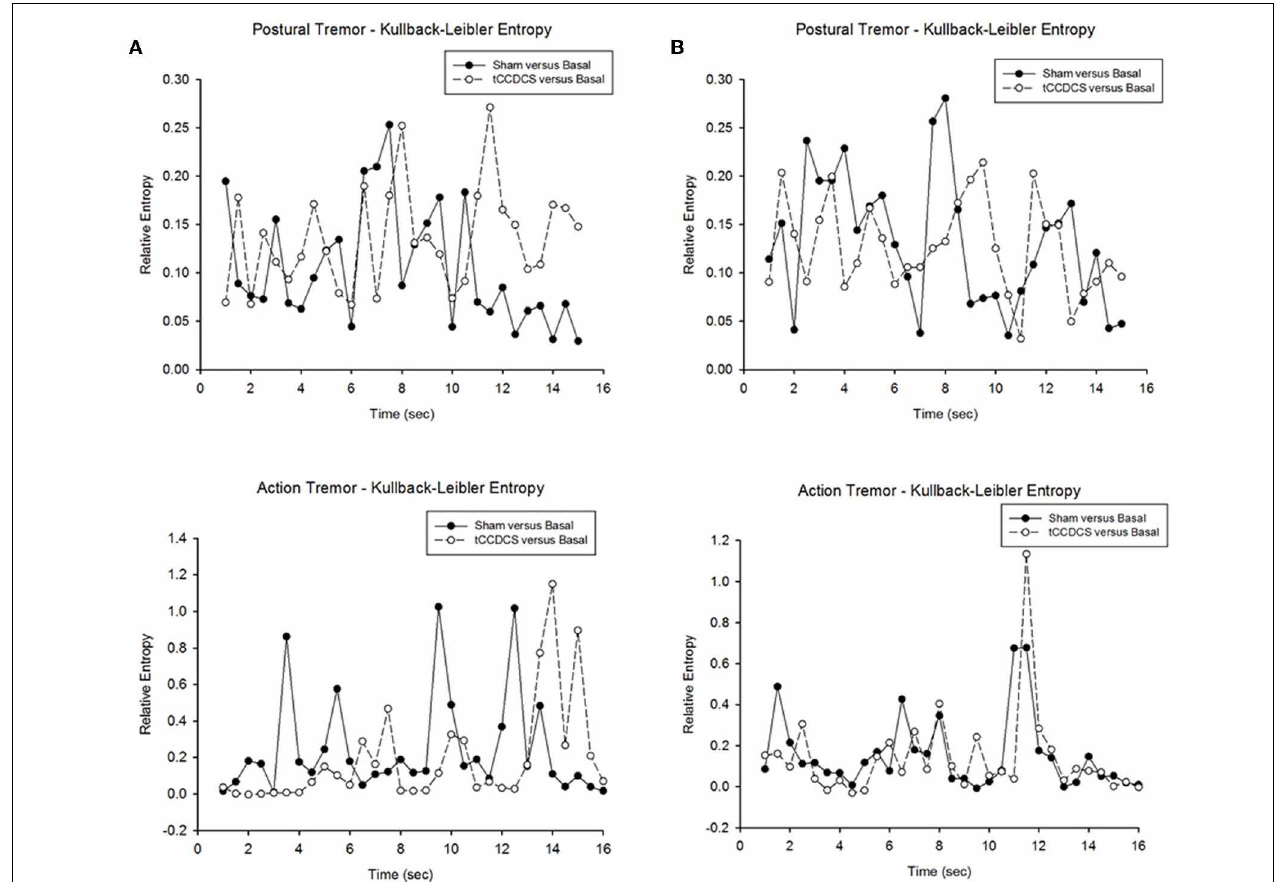
FIGURE 10 | Relative entropy in patient 1 (A) and patient 2 (B). Upper panels correspond to the relative entropy for postural tremor in the condition sham vs. basal (filled circles) and tCCDCS vs. basal (open circles—dotted